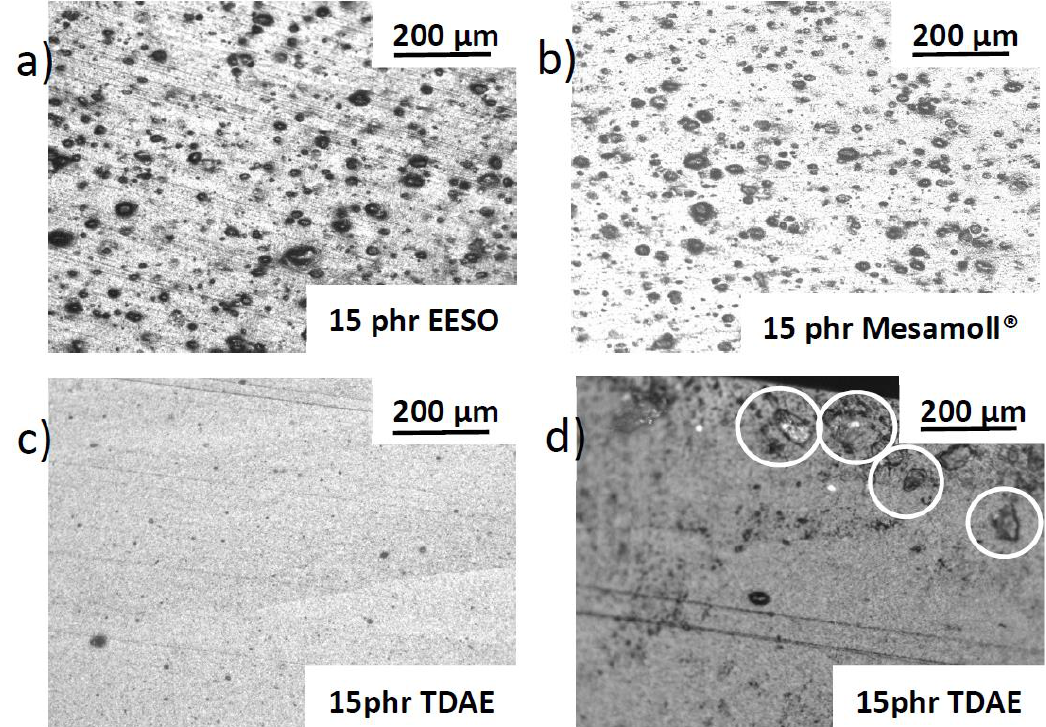
Figure 13. Cross-sectional view of different vulcanized rubber samples; ( a ) NBR-34 vulcanizate with 15 phr EESO, ( b ) NBR-34 vulcanizate with 15 phr Mesamoll ® , ( c ) NBR-34 vulcanizate with 15 phr TDAE (middle of the samples), ( d ) NBR-34 vulcanizate with 15 phr TDAE (circles mark oil).